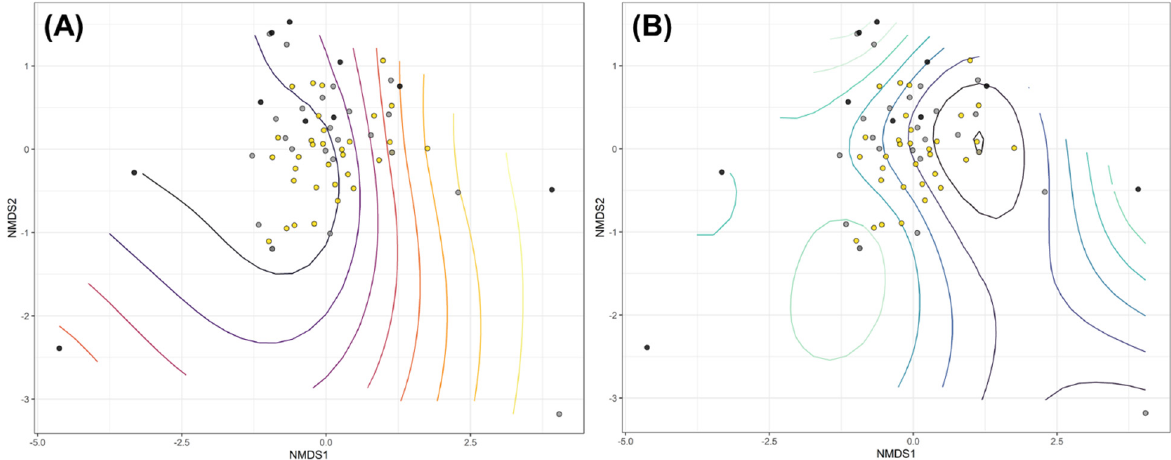
Figure 6. Surf plots of assemblages by ( A ) minimum cave temperature and ( B ) cave elevation, both derived from non-metric multidimensional scaling. Each point represents a single assemblage present in a specific zone of a specific cave, with the distance between them indicating their dissimilarity (i.e., proximate points are similar, distant points are dissimilar). Point colours denote cave zones (black, grey, and yellow denoting dark, twilight, and entrance zones, respectively). Contour colours denote (A) temperature (purple–yellow denoting low–high temperatures) and (B) elevation (dark–light blue denoting low–high elevation). Axes represent a two-dimensional variation in spider assemblages. Most of the assemblages that existed in cooler caves appear to be more similar than those in warmer caves. A complex nonlinear trend is observable between assemblage composition and elevation, with assemblages in intermediate-elevation caves appearing more similar. Average species coordinates are overlaid in the spider plot constructed with the same sample coordinates in Figure S1. Stress = 0.1002019.